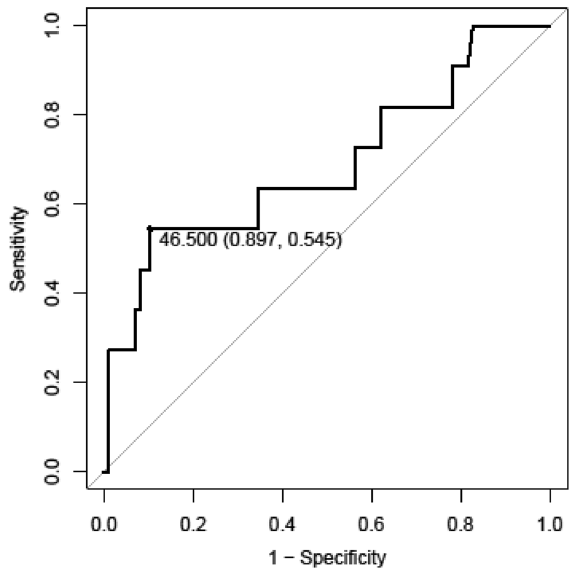
Figure 4. The receiver operating characteristic (ROC) curve of the relationship between the specificity and the sensitivity of the number of CD8 + TILs for lymph node metastasis.